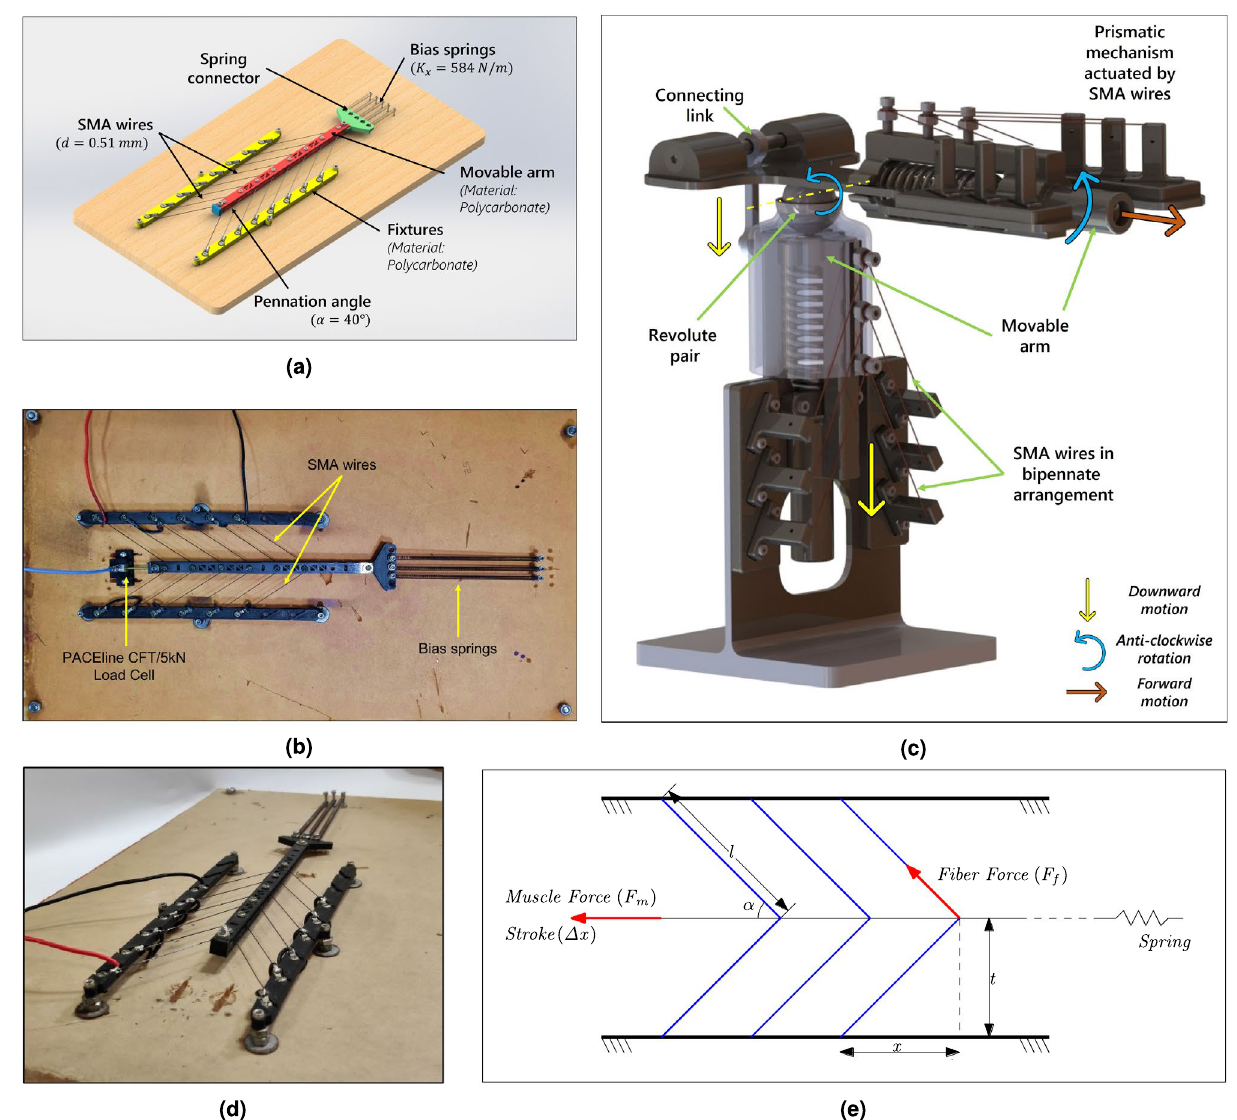
Figure 9. Proposed SMA-based linear actuation system with a bipennate configuration, where the SMA wires have been arranged obliquely. ( a ) depicts the CAD model of the prototype with some of the components mentioned along with their values used for the prototype, ( b , d ) represents the developed proof-of-concept prototype 35 . While ( b ) illustrates the top view of the prototype with electrical connection and bias springs along with the load cell used whereas, ( d ) shows the perspective view of the setup. ( e ) Schematic of the linear actuation system with SMA wires in a bipennate arrangement at any time t , showing the direction of fiber and muscle forces as well as the stroke. ( c ) A 2-DOF revolute-prismatic joint has been proposed deploying bi-planar SMA- based actuators. As shown in the diagram, the connecting link transfers linear motion from the lower actuator to the upper arm, resulting in a revolute joint. The motion of the prismatic pair, on the other hand, is identical to that of the 1st level hierarchical further elongation of the spring. When the voltage becomes zero in the pulsed voltage, the SMA wires elongate on cooling by forced convection and changes its shape reaching twinned martensite phase. Actuator force experiment. The prototype depicted in Fig. 9b is experimentally investigated to assess the performance of the SMA-based bipennate actuator. The experimental setup, as shown in Fig. 10a, consists of a programmable DC power supply to provide input voltage to the SMA wires. As illustrated in Fig. 10b, a piezoelectric load cell (PACEline CFT/5kN) is used to measure the blocked force using a Graphtec GL-2000 data logger. The data is recorded by a host computer for further investigations. A constant power supply is required for the load cell and charge amplifier to obtain the voltage signal. The corresponding signal is converted to force output based on the sensitivity and other parameters of the piezoelectric force transducer as mentioned in Table 2. The SMA wire temperature increases when a voltage pulse is applied, resulting in the contraction of the